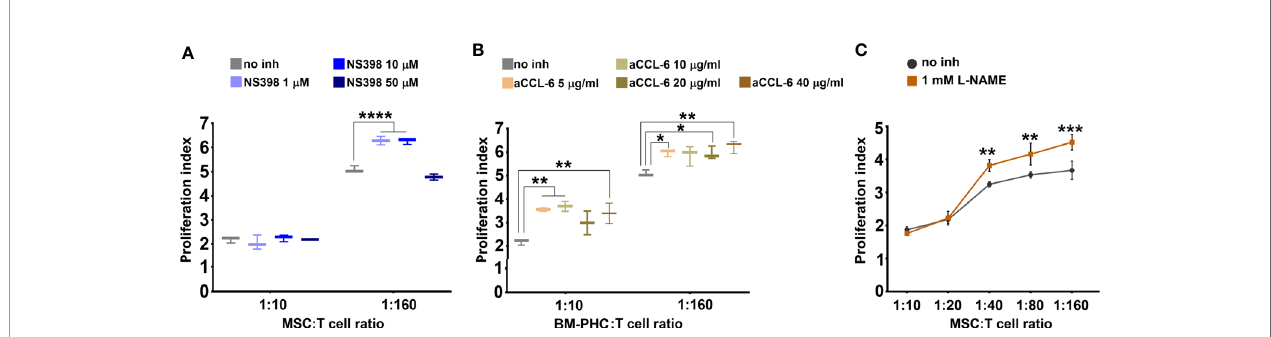
FIGURE 4 | The effects of cells on T cell proliferation in the presence of inhibitors. (A) Effect of different doses of NS398, a speci fi c COX-2 inhibitor, on reversing the inhibitory effect of MSC. Note the capacity of NS398 at 1 and 10 µM to partially reverse the MSC effect on T cell proliferation at the lowest MSC: T cell ratio. (B) Effect of different doses of CCL-6 neutralizing antibody on reversing the inhibitory effect of BM-PHC. Note the reversing effects of anti-CCL-6 at both BM-PHC: T cell ratios. The graphics in a-b illustrate a representative experiment from at least four experiments performed with different batches, with the same conclusions. (C) Effect of L-NAME, a speci fi c NO synthase inhibitor, on reversing the inhibitory effect of MSC. The graphic illustrates a representative experiment from three experiments preformed with different L-NAME doses: 100 nM, 500 nM, and 1mM. No dose-dependent effect of L-NAME was observed, yet the three doses produced the same reversing effects. *p < 0.05, **p < 0.01, ***p < 0.005,